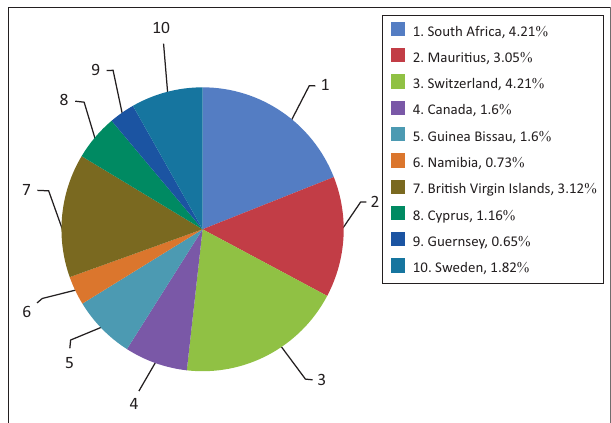
FIGURE 5: Top 10 countries 3 according to increase in contribution above 75th